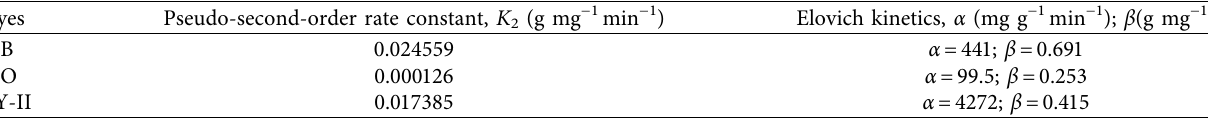
Table 5: Values for significant factors obtained from the kinetics of sorption.